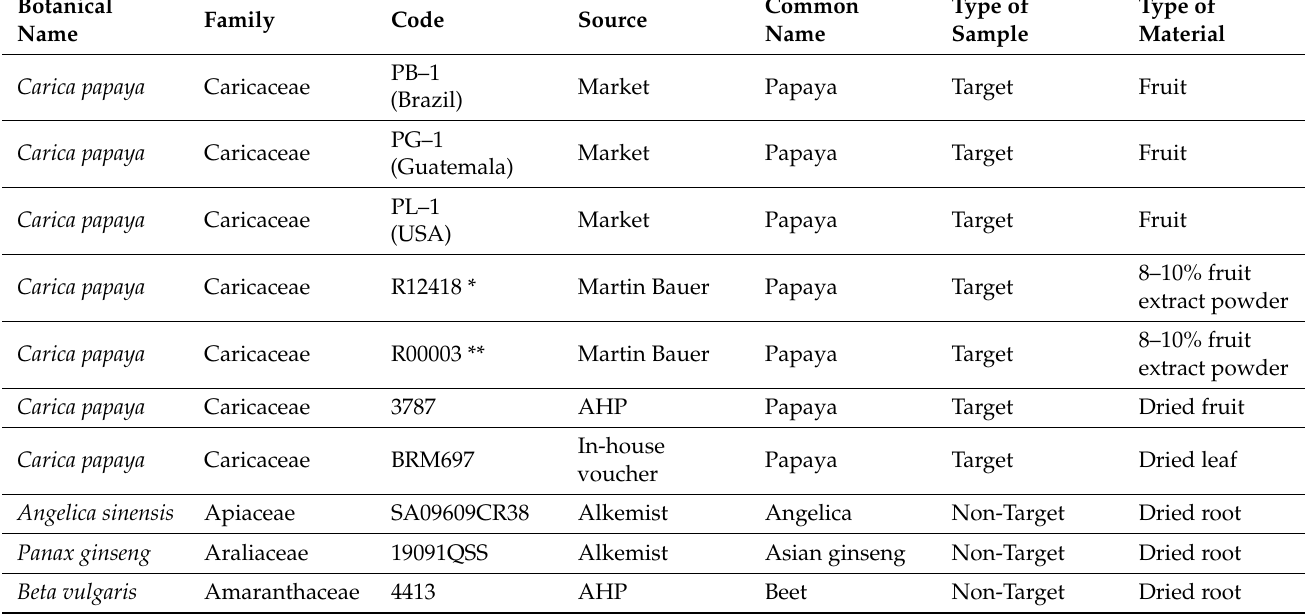
Table 1. Target and non-target samples used for validation of Carica papaya